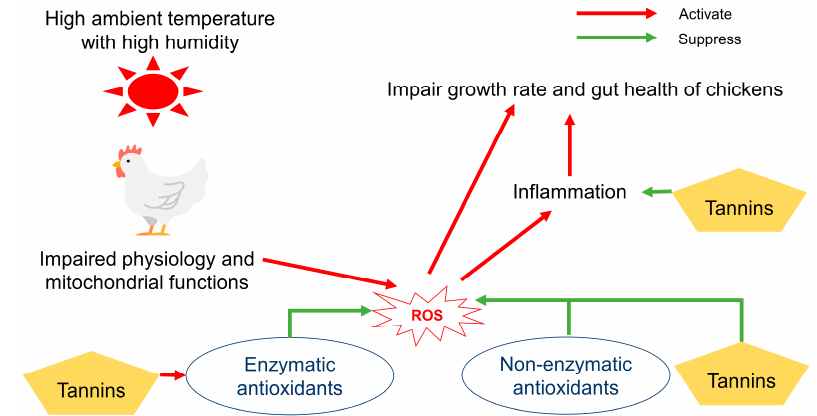
Figure 3. Potential mechanisms for the alleviating effects of tannins in heat-stressed chickens. High ambient temperature with high humidity increase core body temperature of chickens, and this can result in impaired physiology and mitochondrial functions, which lead to excessive reactive oxygen species (ROS) [127]. Tannins, polyphenolic compounds, directly scavenge ROS like non-enzymatic antioxidants [128], and also, tannins can increase activities of antioxidant enzymes such as superoxide dismutase (SOD), glutathione peroxidase (GPX), and glutathione reductase (GR) in broiler chickens. The ROS cause inflammation that can impair growth rate and gut health of chickens and tannins also have anti-inflammatory function